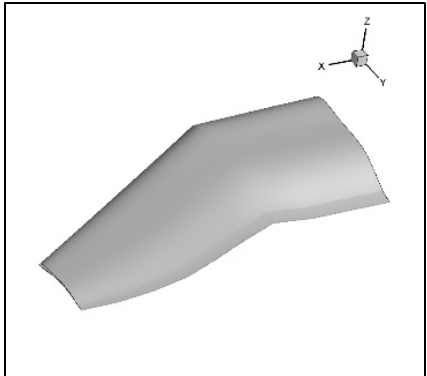
Figure 2. Geometric model of a seagull wing.